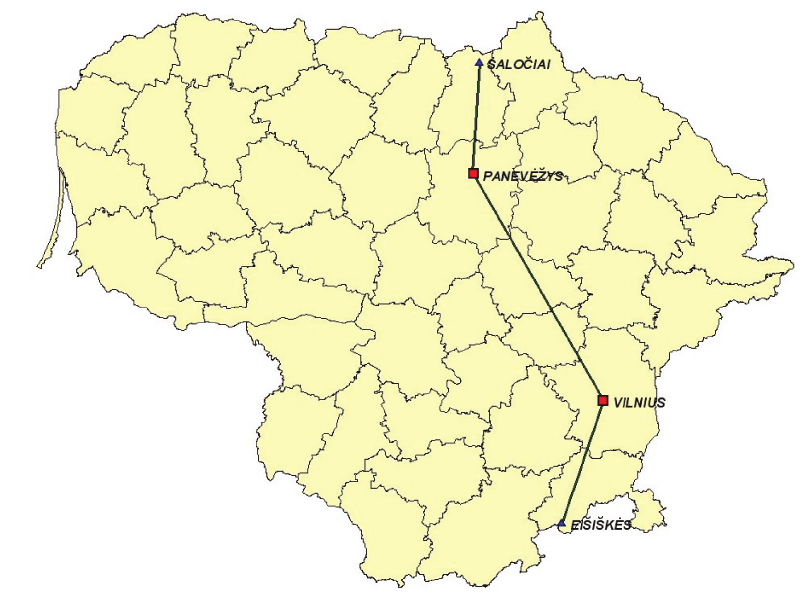
Fig. 1. The points of gravimetric calibration base